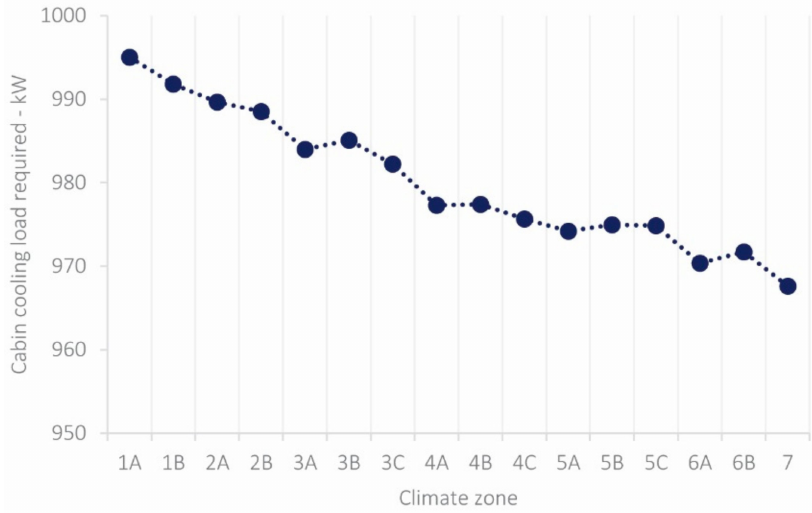
Figure 5. Simulated average cabin load over 16 climate